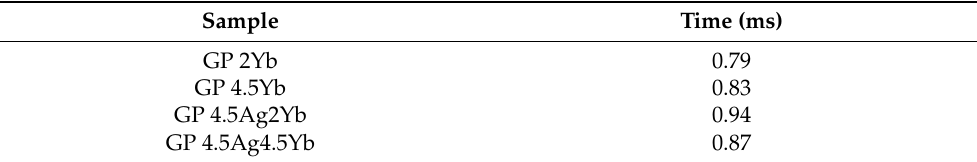
Figure 9 . Yb 3+ ions PL decay curves under 405 nm excitation with detection at 980 nm for GP 2Yb, GP 4.5Yb, GP 4.5Ag2Yb, and GP 4.5Ag4.5Yb samples. Table 4 . PL decay lifetimes for GP 2Yb, GP 4.5Yb, GP 4.5Ag2Yb, and GP 4.5Ag4.5Yb samples under 405 nm excitation with detection at 980 nm.